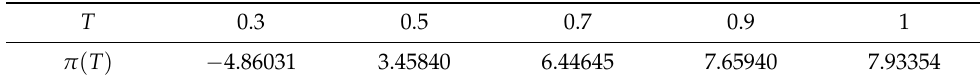
Table 4. Related profits for Example 2.